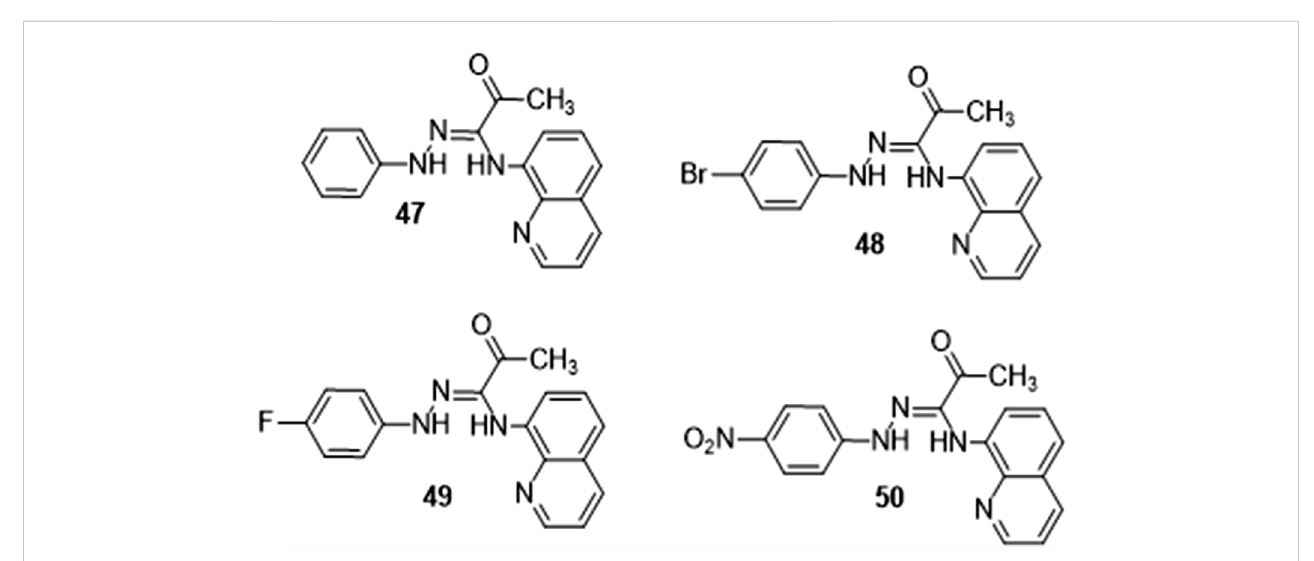
FIGURE 10 Derivatives with anti-in fl ammatory